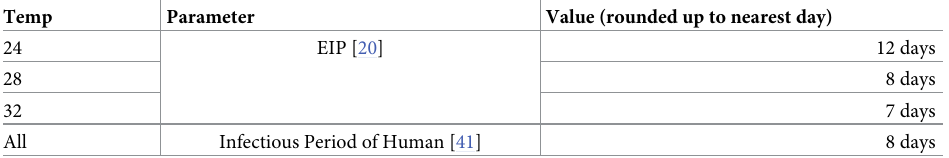
Table 1. Parameter values for the models were either generated in the Christofferson laboratory or taken from the literature.